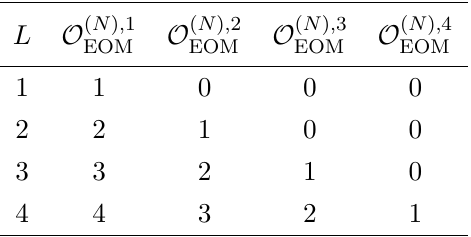
Table 2 . The table summarizes the loop orders for which the mixing of O ( N ) given a certain loop order of Γ N